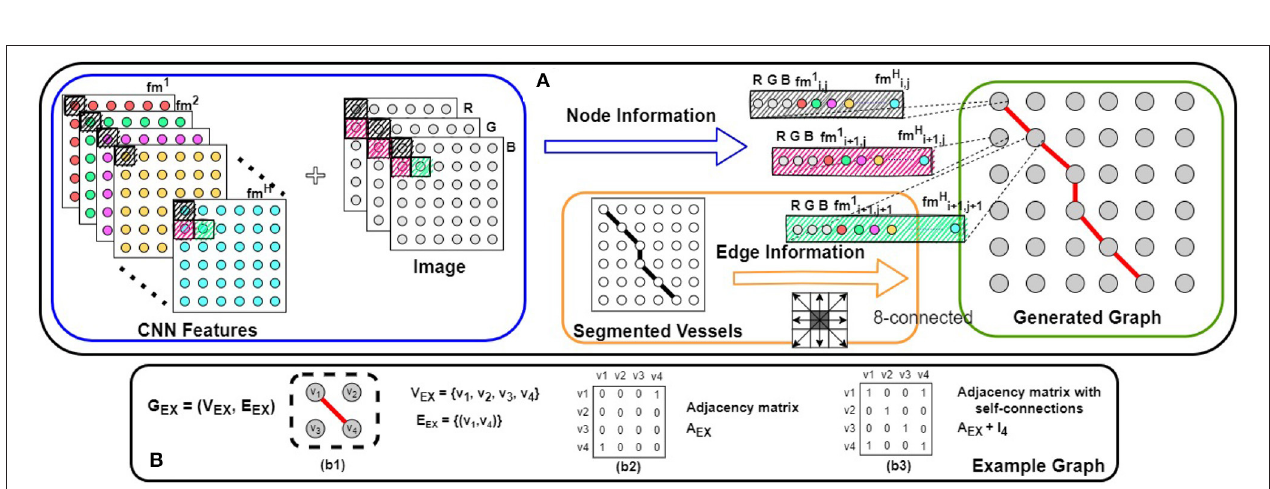
FIGURE 3 | (A) Our proposed method for graph representation generation. Combining the input image with the CNN features (shown in the blue box), node features are assigned to the graph. Using the segmented vessel structure, the edge connectivity is determined (shown in the orange box). Combining these two types of information, our graph representation is generated (shown in the green box). In (B) , a simple example of an undirected graph [ G EX = ( V EX , E EX )] is shown; (b2,b3) the adjacency matrix ( A ) and the adjacency matrix with self-connections ( ˆ A ) of this graph.